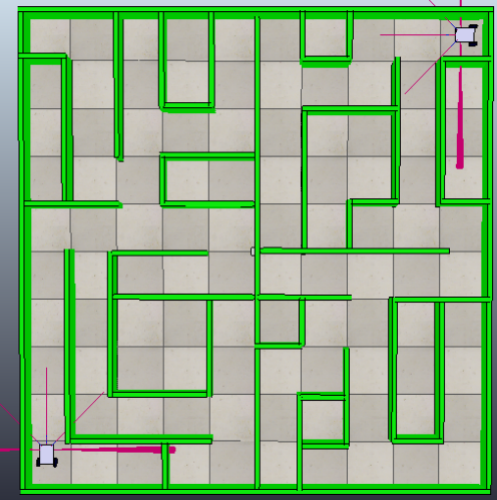
Figure 7. Experiment with two robotic